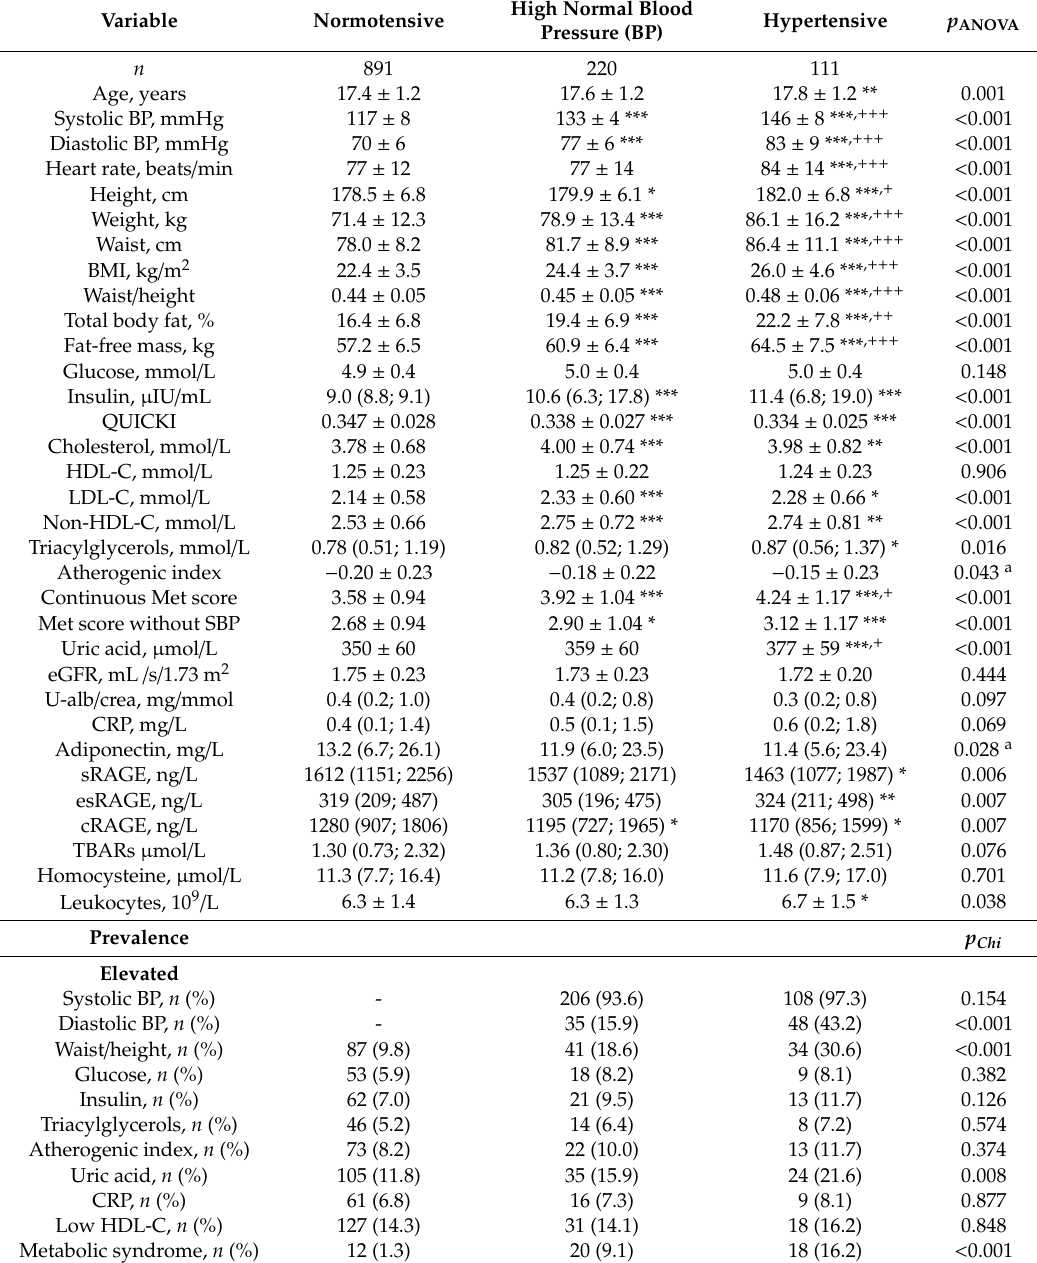
Table 2. Characteristics of